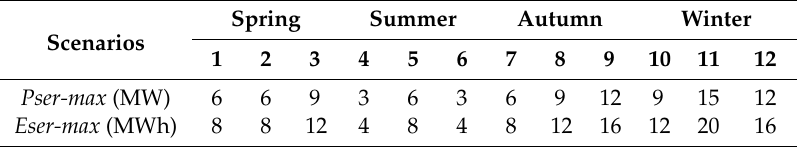
Table 3. The stable energy storage capacity allocated to improve VPP output.